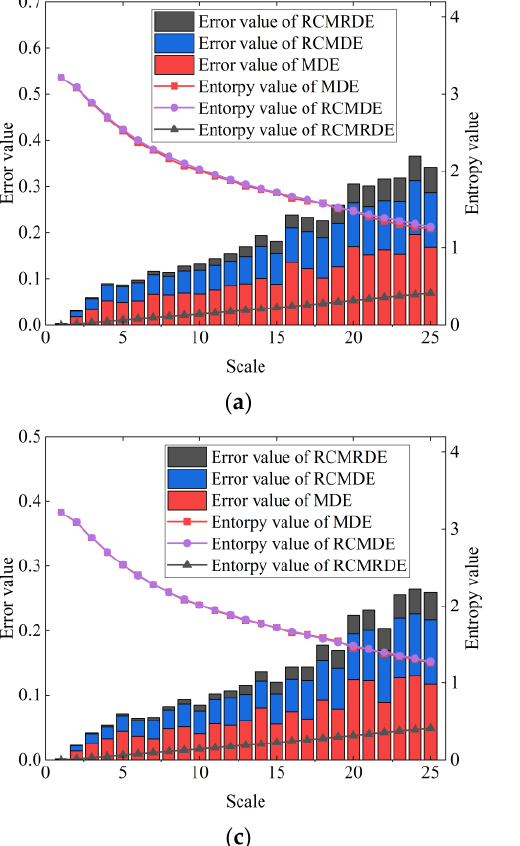
Figure 1. The mean curve and error value of MDE, RCMDE and RCMRDE for white noise with different N : ( a ) N = 2048; ( b ) N = 3072; ( c ) N = 4096; ( d ) N = 5120.